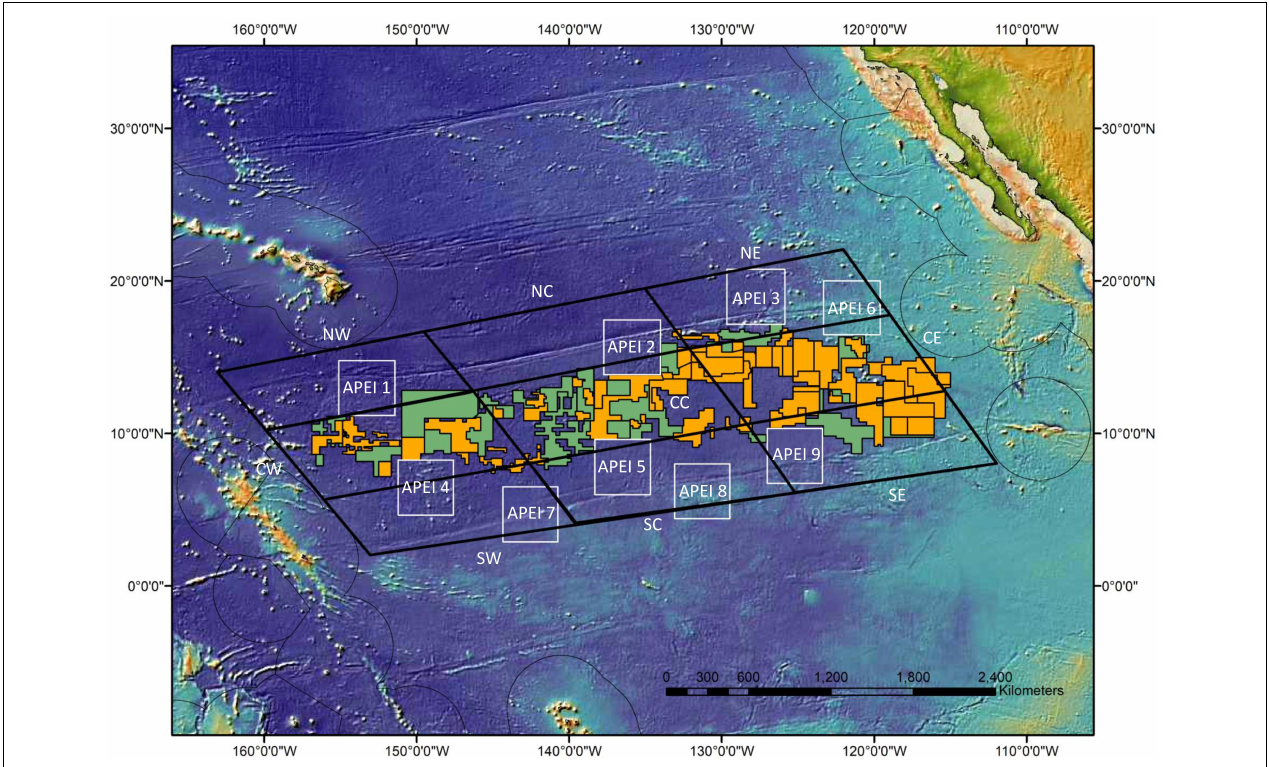
FIGURE 1 | CCZ environmental subregions (large black-outlined parallelograms—NW = northwest, NC = north-central, NE = northeast, CW = central-west, CC = central, CE = central-east, SW = southwest, SC = south-central, and SE = southeast CCZ blocks), exploration areas (orange), reserve areas (green), and APEIs (1–9, outlined in white). APEIs were located by the ISA (2011) to be representative of respective subregions as follows: NE – 1, NC – 2, NE -3, CW – 4, CC – 5, CE – 6, SW – 7, SC – 8, SE – 9. Darker blues represent deeper depths, for values see Supplementary Figure 1